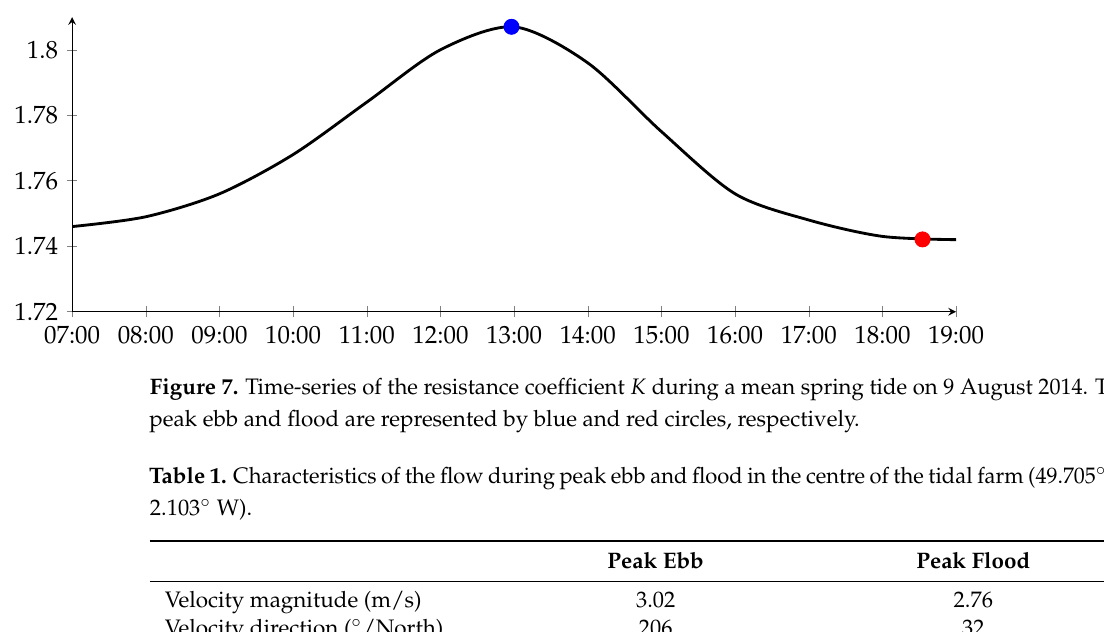
Figure 6. Evolution of the thrust coefficient as a function of the induction factor for the case with blockage correction (red curve) and for the case without blockage corrections (blue curve). The values of Fr and B are calculated from the averaged values of velocities and water depth retained for our application in the Alderney Race (Section 3, Table 1) ( Fr = 0.152 and B = 0.09).